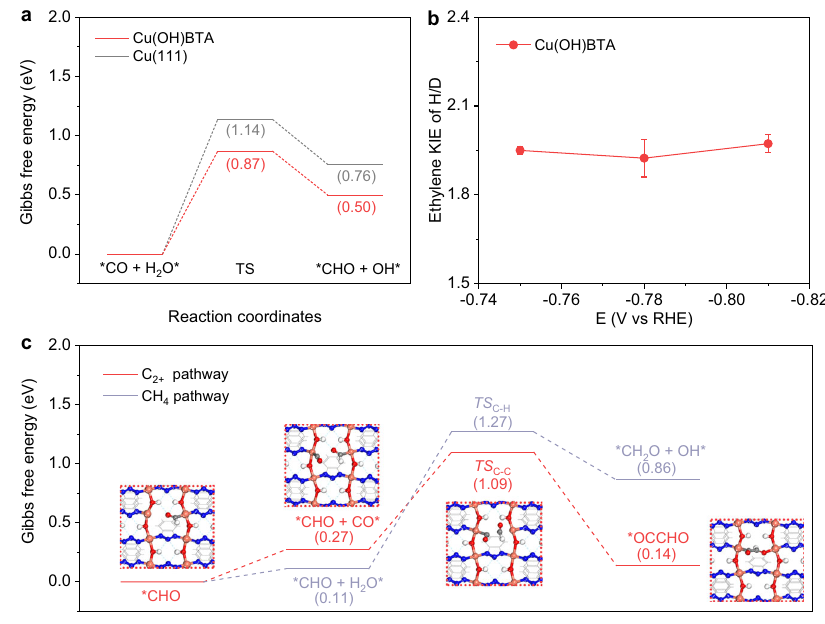
Fig. 4 | Investigation of Cu(OH)BTA stability under CO 2 RR. a Gibbs free energy diagramofhydrogenationof*COonCu(OH)BTAslabandCu(111)slab. b KIEofH/D inCO 2 RRonCu(OH)BTAunderthepotentialrangefrom − 0.75to − 0.81V.Theerror bars for ethylene KIE uncertainty represent one standard deviation based on three